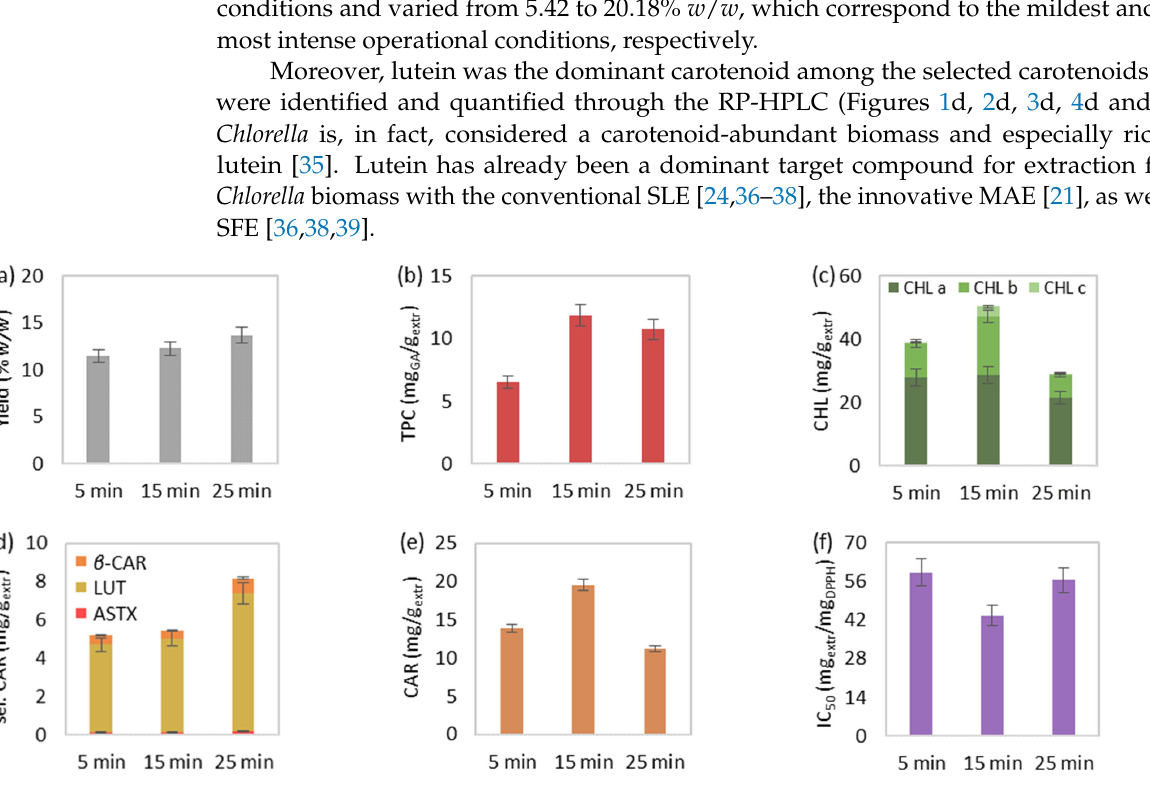
Figure 1. The effect of extraction duration on MAE’s ( a ) extraction yield, extract’s total ( b ) phenolic and ( c ) chlorophyll content, ( d ) selected and ( e ) total carotenoid content, and ( f ) antioxidant activity. The extraction conditions of the single ‐ factor experiments were maintained at 55 mL solv /g biom , 50 °C and 550 watts.